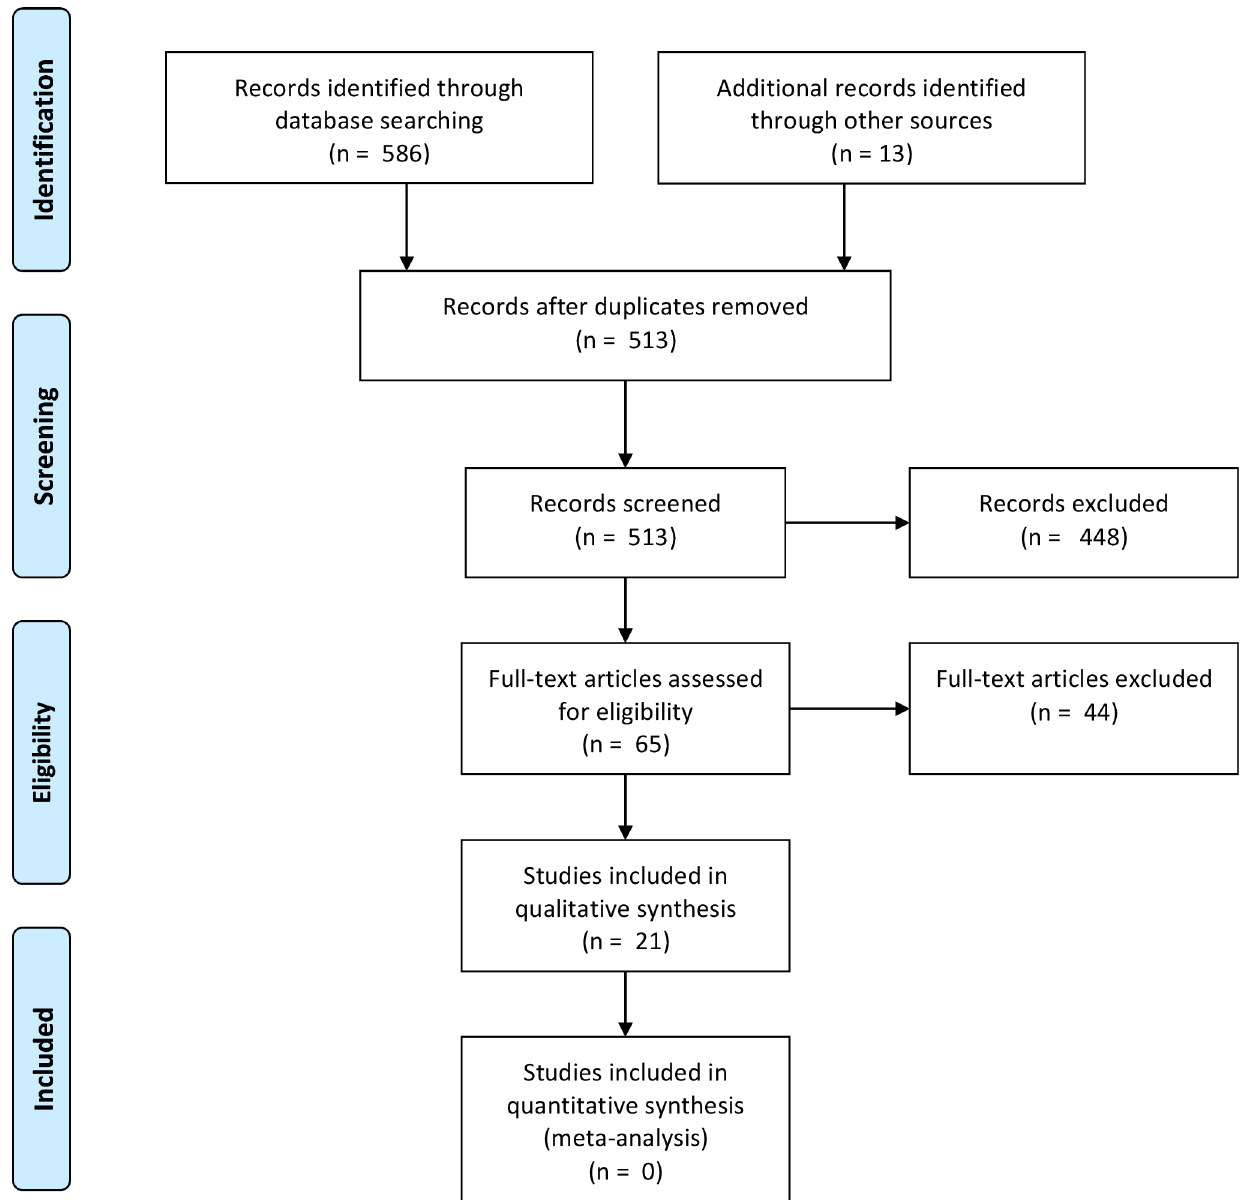
Fig 1. Flowchart of the literature review selection